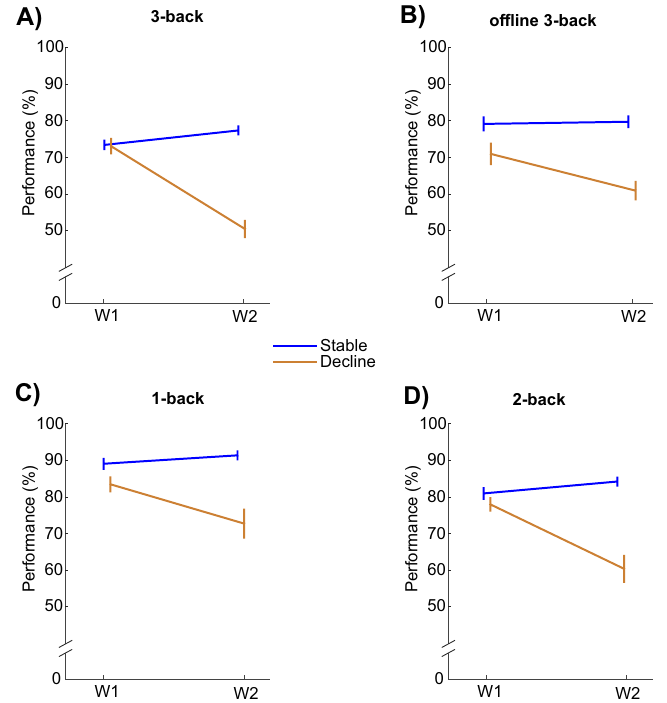
Figure 1. Heterogeneity in WM trajectories. Longitudinal 3-back trajectories ( A , B ) classified individuals into stable versus declining WM. The distinction generalized to lower levels of WM load ( C , D ). (Mean ± 1SE). W =